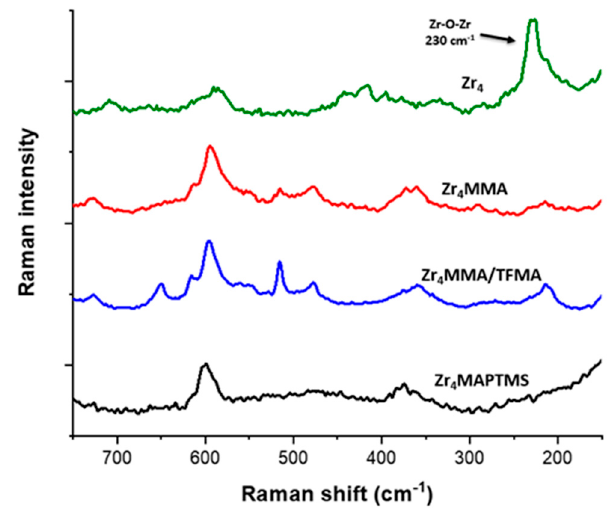
Figure 3. Raman measurements of Zr 4 -oxocluster, Zr 4 MMA and Zr 4 MMA/TFMA hybrids in the region between 150 and 750 cm − 1 .